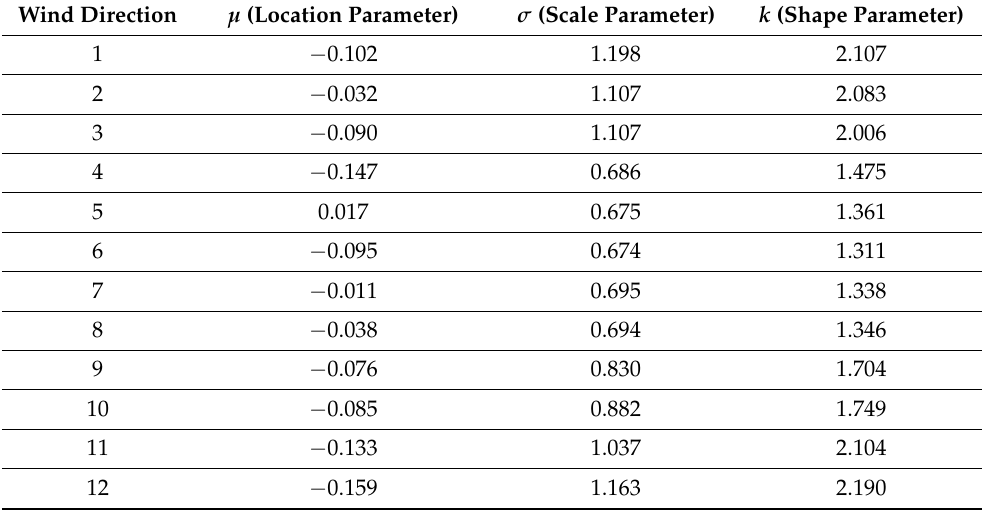
Table 3. Probability density function parameters of wind velocity at all azimuth angles. Wind